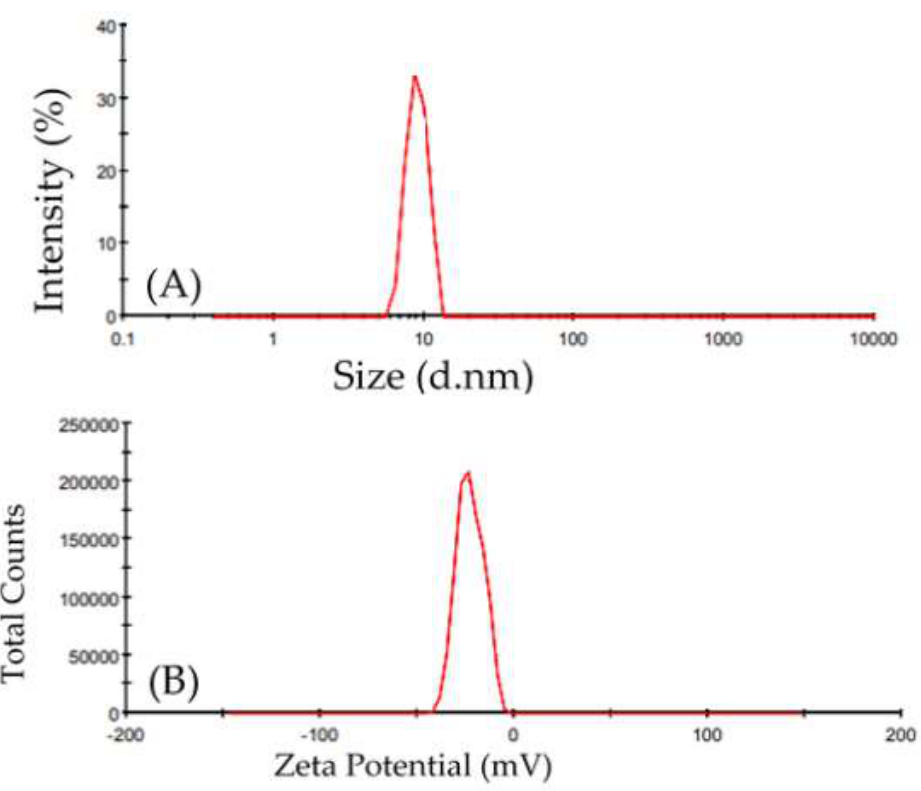
Figure 6. ( A ) Zeta size of nanoparticles synthesized of zinc oxide (Z-average (d.nm): 8.903, PdI: 0.242, and intercept: 0.88), ( B ) Zeta potential of zinc oxide nanoparticles produced via green synthesis (Zeta potential (mV): −22.6, Zeta deviation (mV): 6.9, and conductivity (mS/cm): 0.0113).